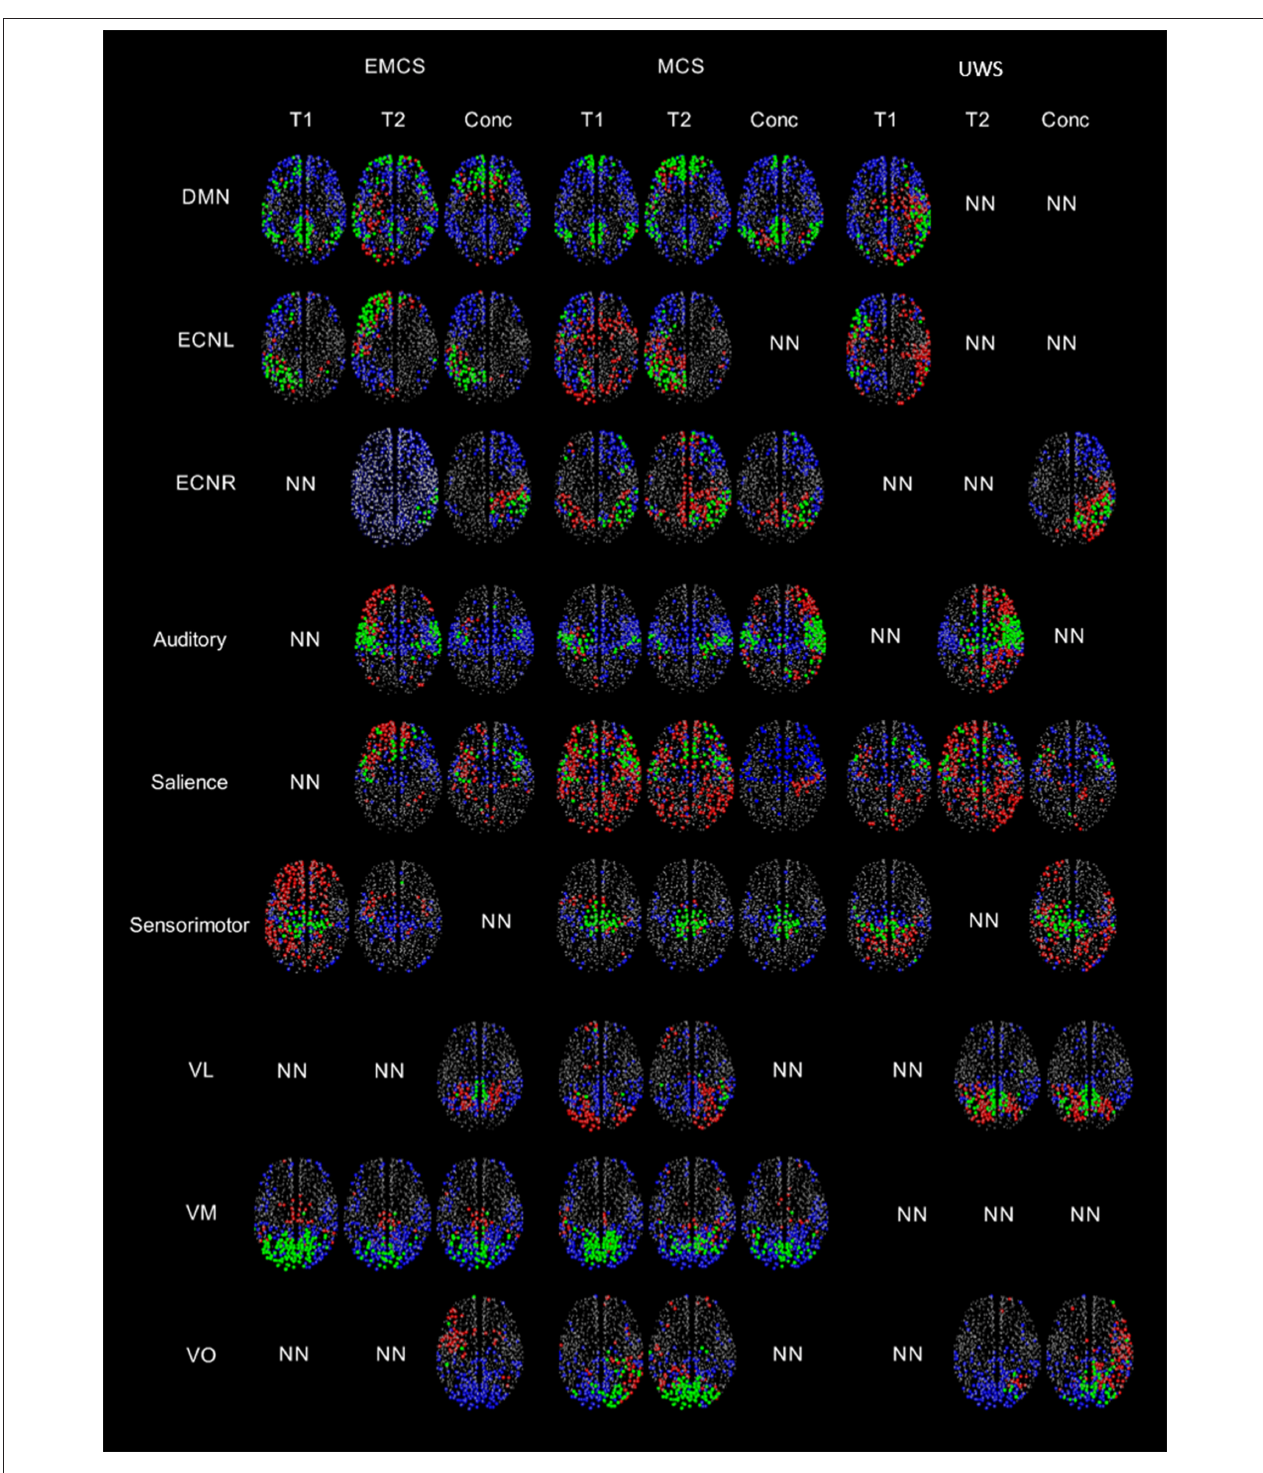
FIGURE 3 | A visual representation of the regions highlighted by the thresholded GS (values greater than half of the maximum GS value for the network), separated by the regions within and outside the network for patients in EMCS, MCS and UWS for nine RSNs. Regions belonging to the network and having GS values greater than the thresholded GS are represented by green, regions which should be in the network but do not have GS values greater than the thresholded GS are represented by blue, regions outside the network but have GS values greater than the thresholded GS are represented by red color. NN represents non-neuronal networks. Here the size of the circle doesn’t represent the value of the GS, all the regions with a GS value are plotted evenly.